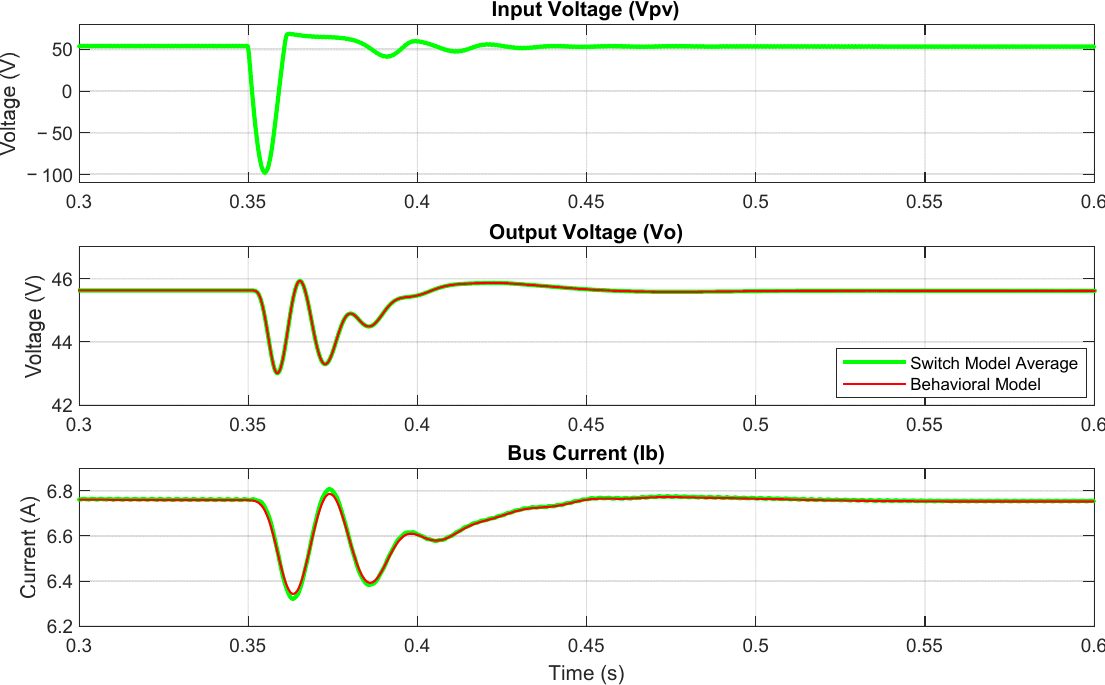
Figure 12. Output voltage and bus current waveforms comparison for step change in PV input voltage.